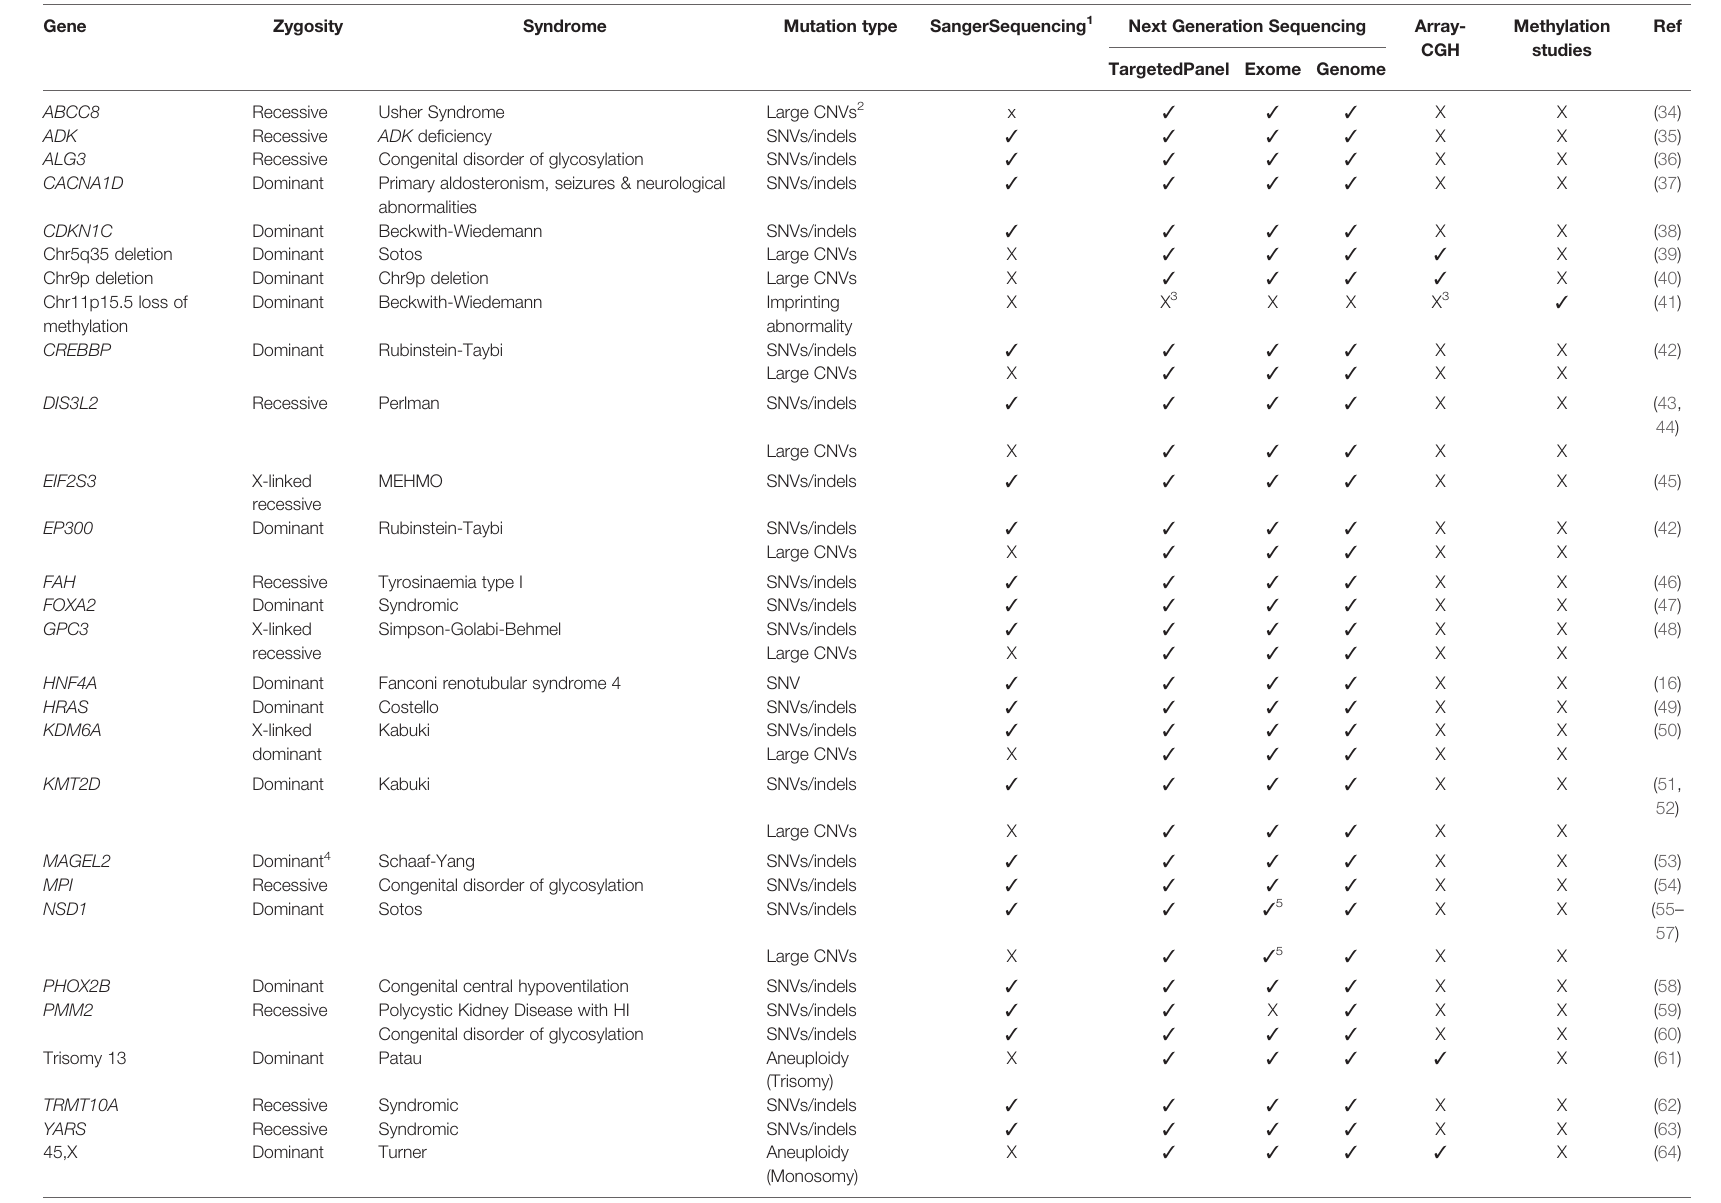
TABLE 2 | Known genetic causes of syndromic disease in which congenital hyperinsulinism can be a rare or common feature and the current approaches to genetic testing for this condition. A tick ( ✓ ) or cross (X) denote whether the form of genetic variation can be detected by the screening approach. Methylation studies refer to methodologies that can detect changes in DNA methylation patterns (e.g. Epic array analysis, Methylation- speci fi c MLPA). SNVs are single nucleotide variants, Indels are insertion/deletion variants and CNVs are copy number variants (deletions and